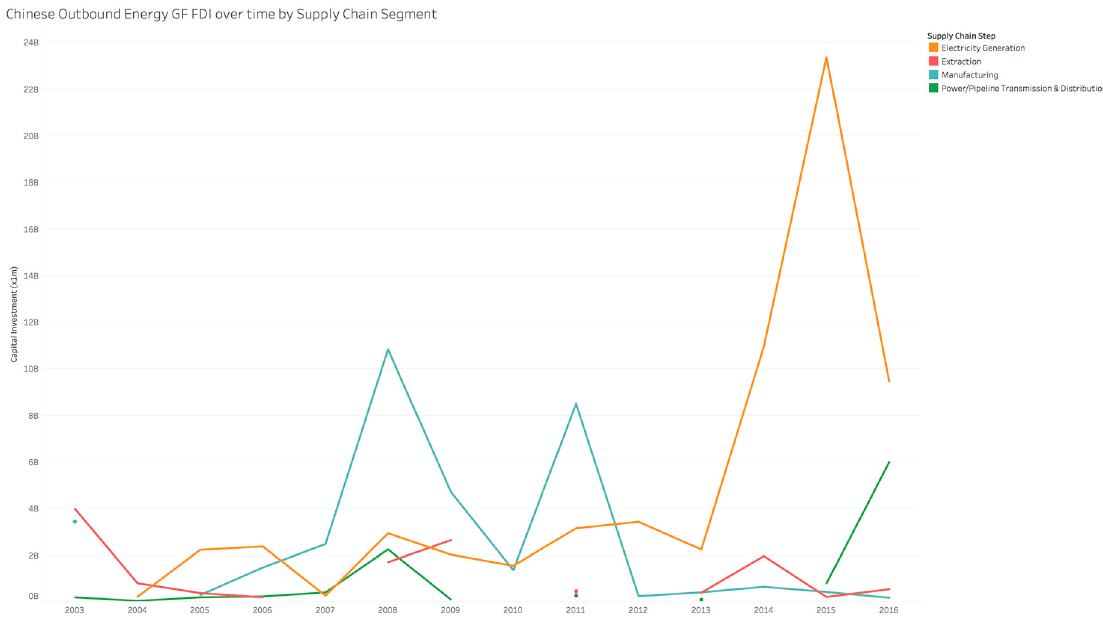
Figure 14. Growth of China’s outbound energy GF FDI investment by supply chain steps.